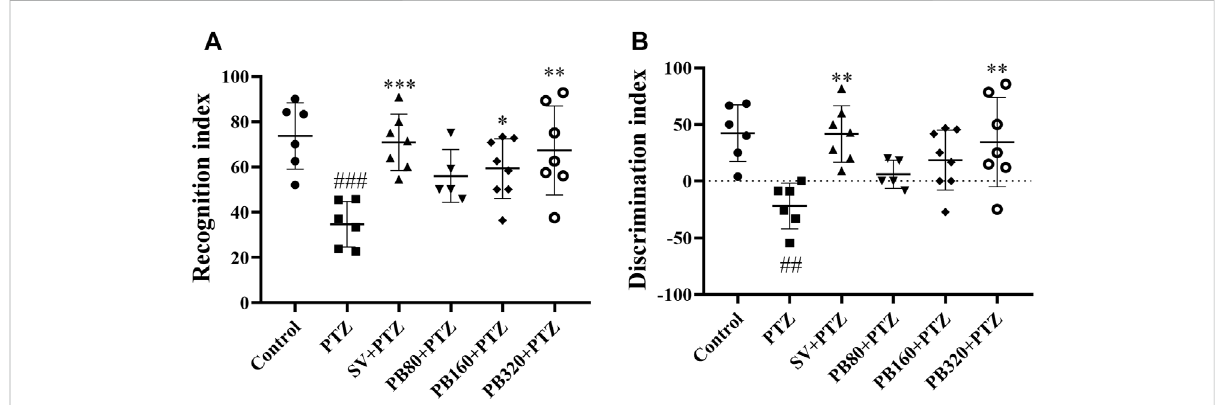
FIGURE 4 The aqueous extract of P. biglobosa increased both the recognition index (A) and discrimination index (B) during the object recognition test. Results are expressed as mean percentage ± SEM, N = 8. Data were analyzed by one-way ANOVA, followed by Tukey (HSD). ### p < 0.001; ## p < 0.01 comparedto thecontrol group and *** p < 0.001; ** p < 0.01; * p < 0.05 comparedto the PTZ group. Control, normal control group only treated with distilled water; PTZ, negative control group treated with distilled water and PTZ; PB80, PB160, PB320 + PTZ, test groups treated with the aqueous extract of P. biglobosa (80, 160, and 320, respectively) and PTZ; SV + PTZ, positive control group treated with sodium valproate and PTZ. PTZ, pentylenetetrazole. SV, sodium valproate; PB, Parkia biglobosa